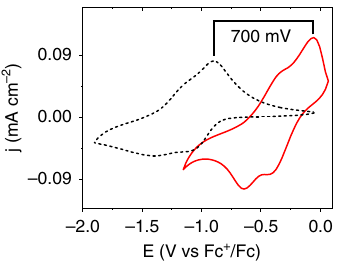
Fig. 5 Photoelectrochemical characterization of modi fi ed GaP photocathodes. Cyclic voltammograms of Zr(NDI)@FTO (black dashed) and an illuminated Zr(NDI) ∣ TiO 2 @GaP working electrode (red) at a scan rate of 100 mV s − 1 with 0.5 M LiClO 4 in DMF as the supporting electrolyte. The red solid data were collected under AM 1.5 illumination.